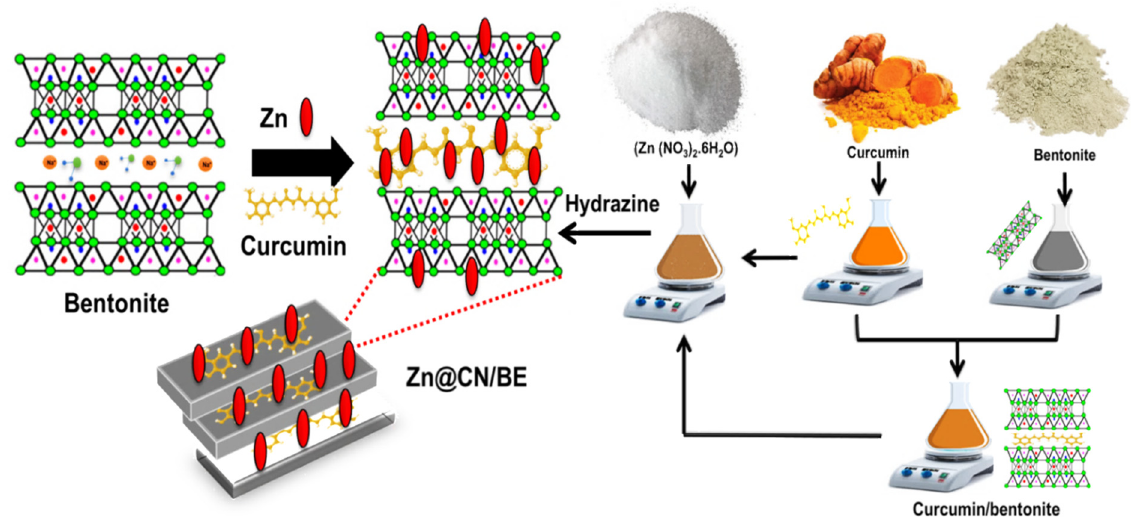
Figure 8. Schematic diagram for the synthesis procedures of the Zn@CN/BE composite.